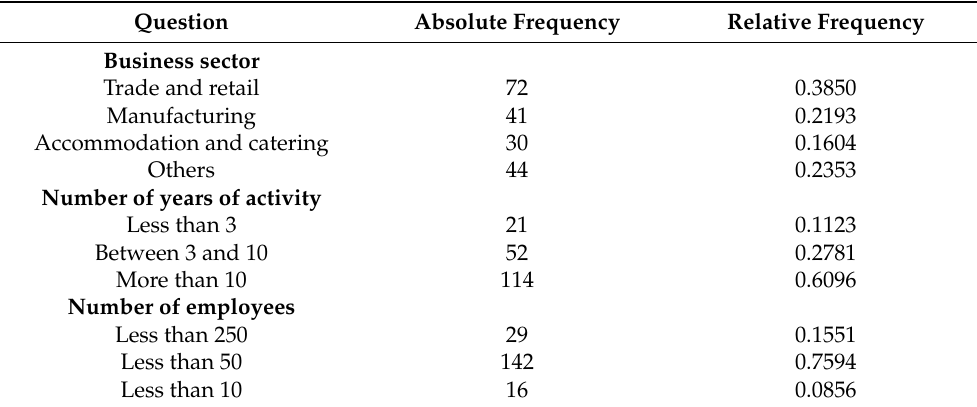
Table 2. Characterization of the